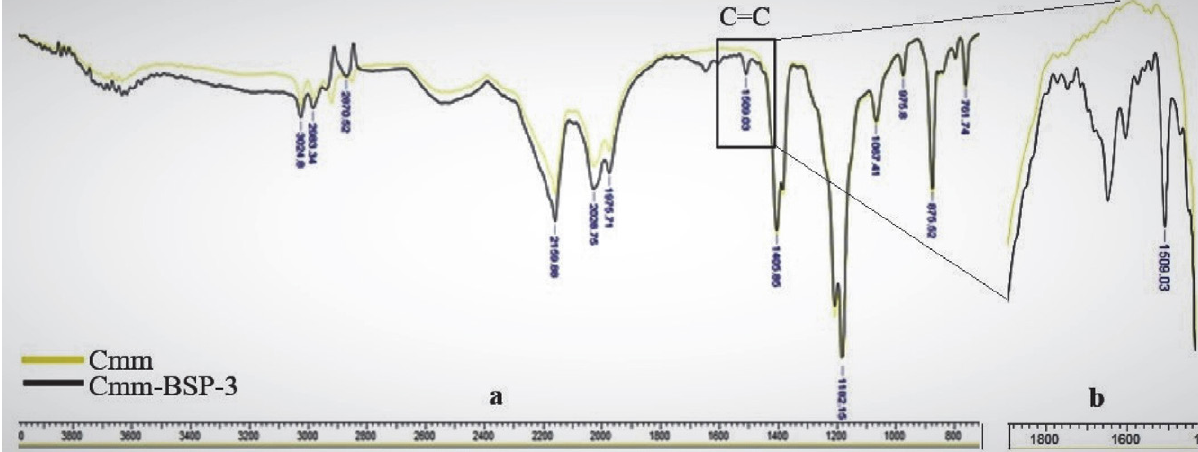
Şener et al.: Synthesis of Adenine-based Fluorescent ...